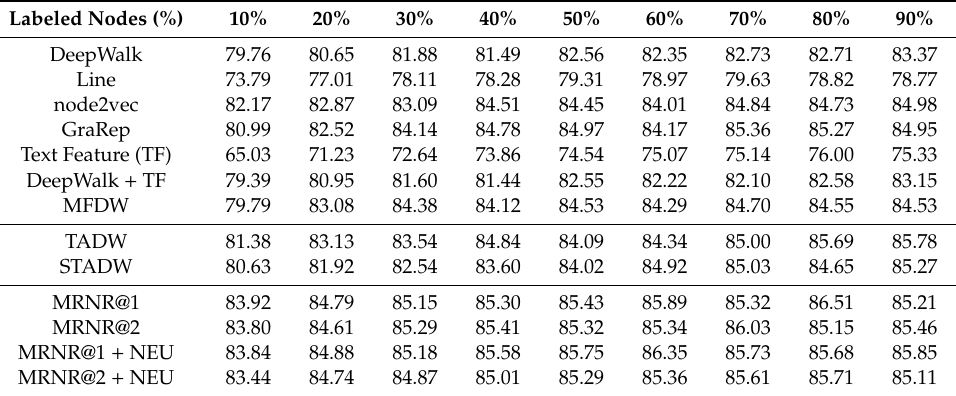
Table 6. Accuracy (%) of vertex classification on the SDBLP